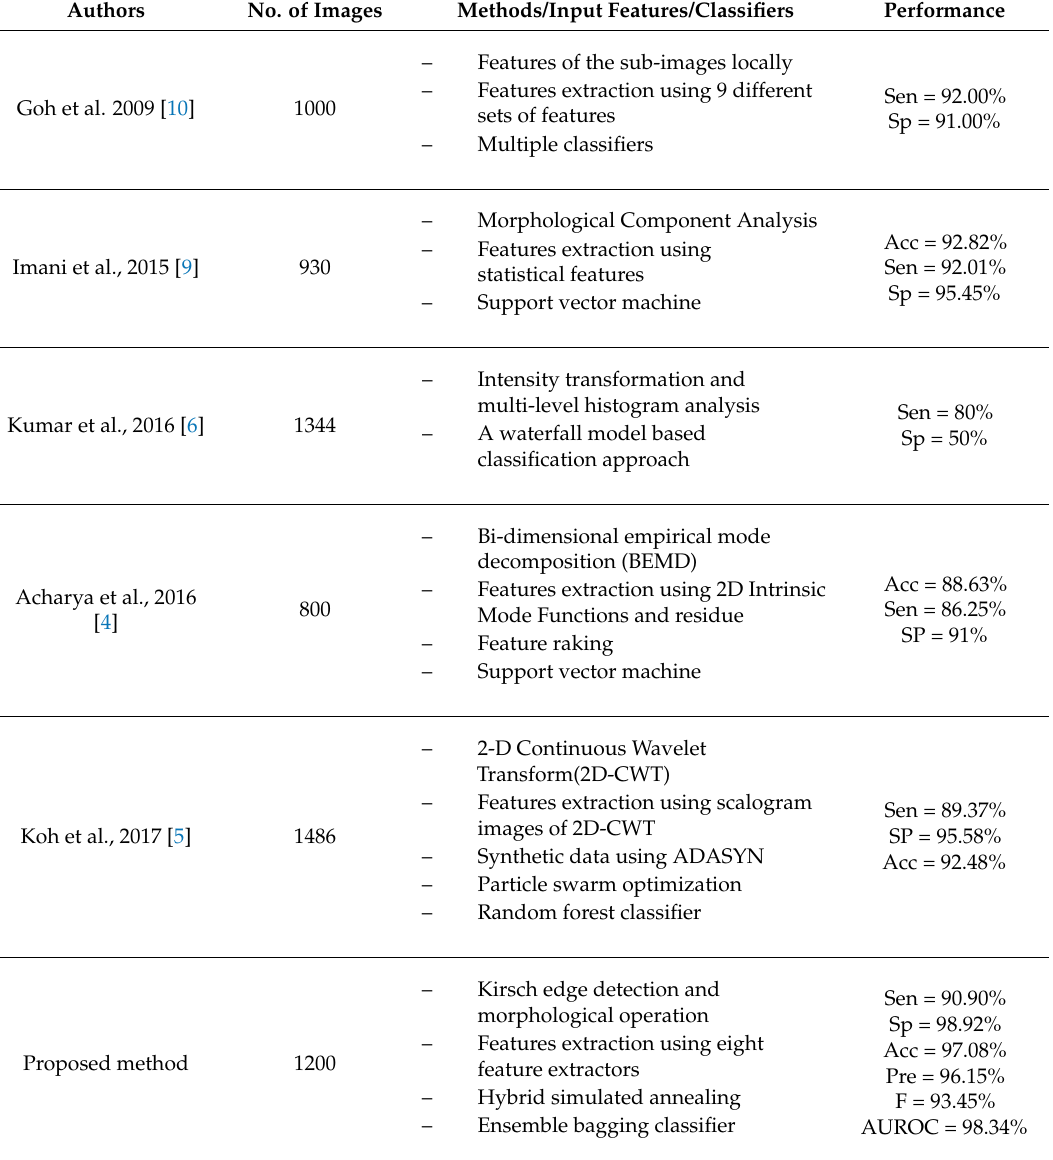
Table 8. Comparison of the proposed method with previous